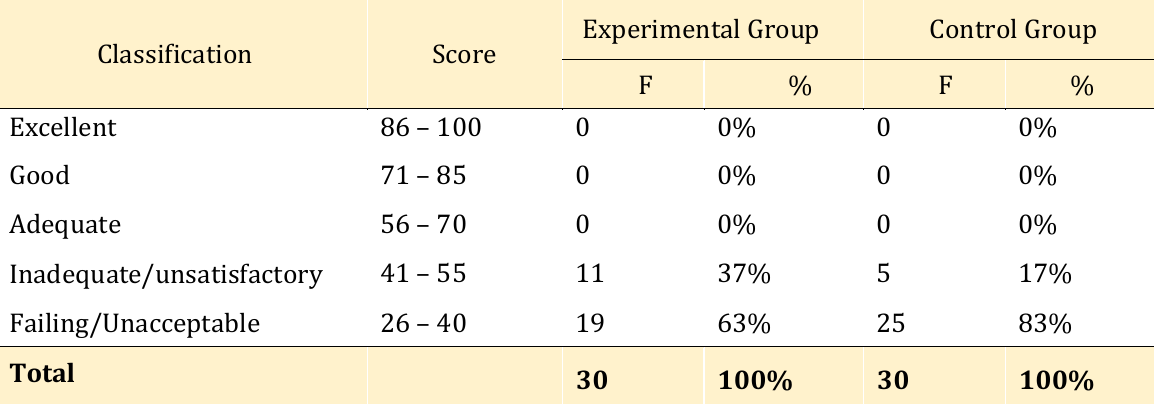
Table 5. The Frequency and Percentage of Students’ Achievement in term